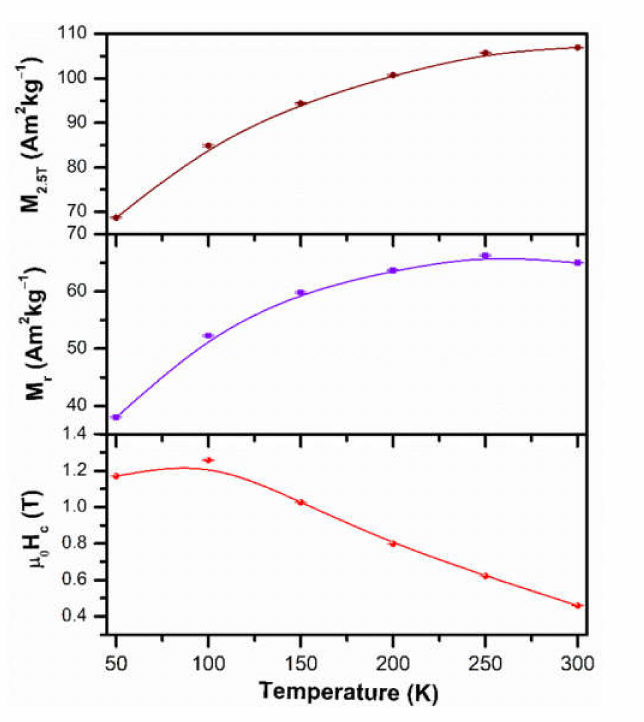
Figure 8. Saturation magnetization, remanence and coercivity Nd 1.1 Fe 10 CoTiN x alloy nitrogenated during 6 h and as a function of temperature. The specimen was not magnetically